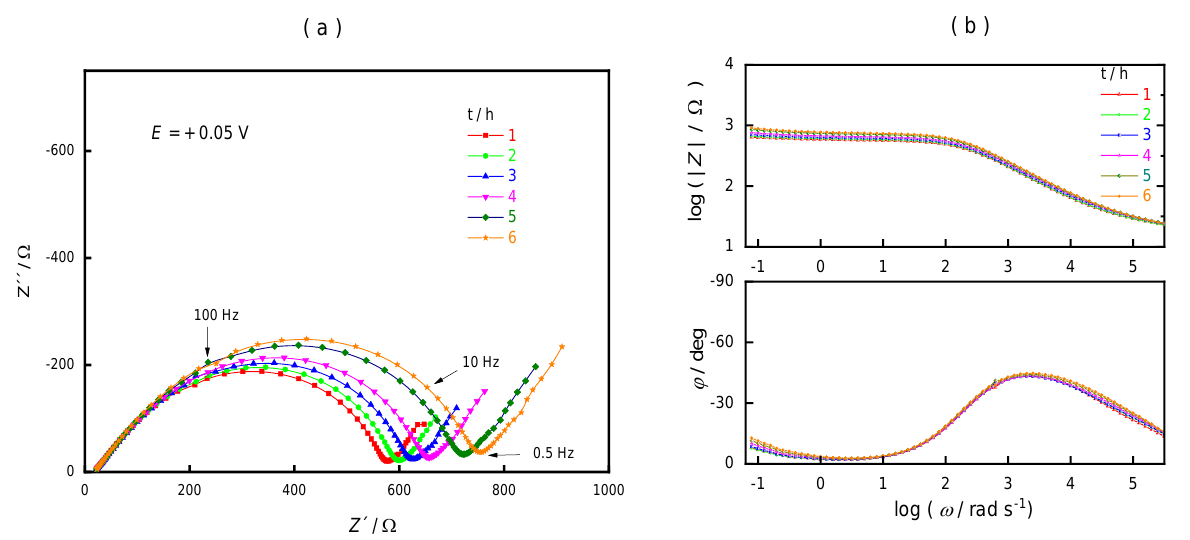
0 02004006008001000